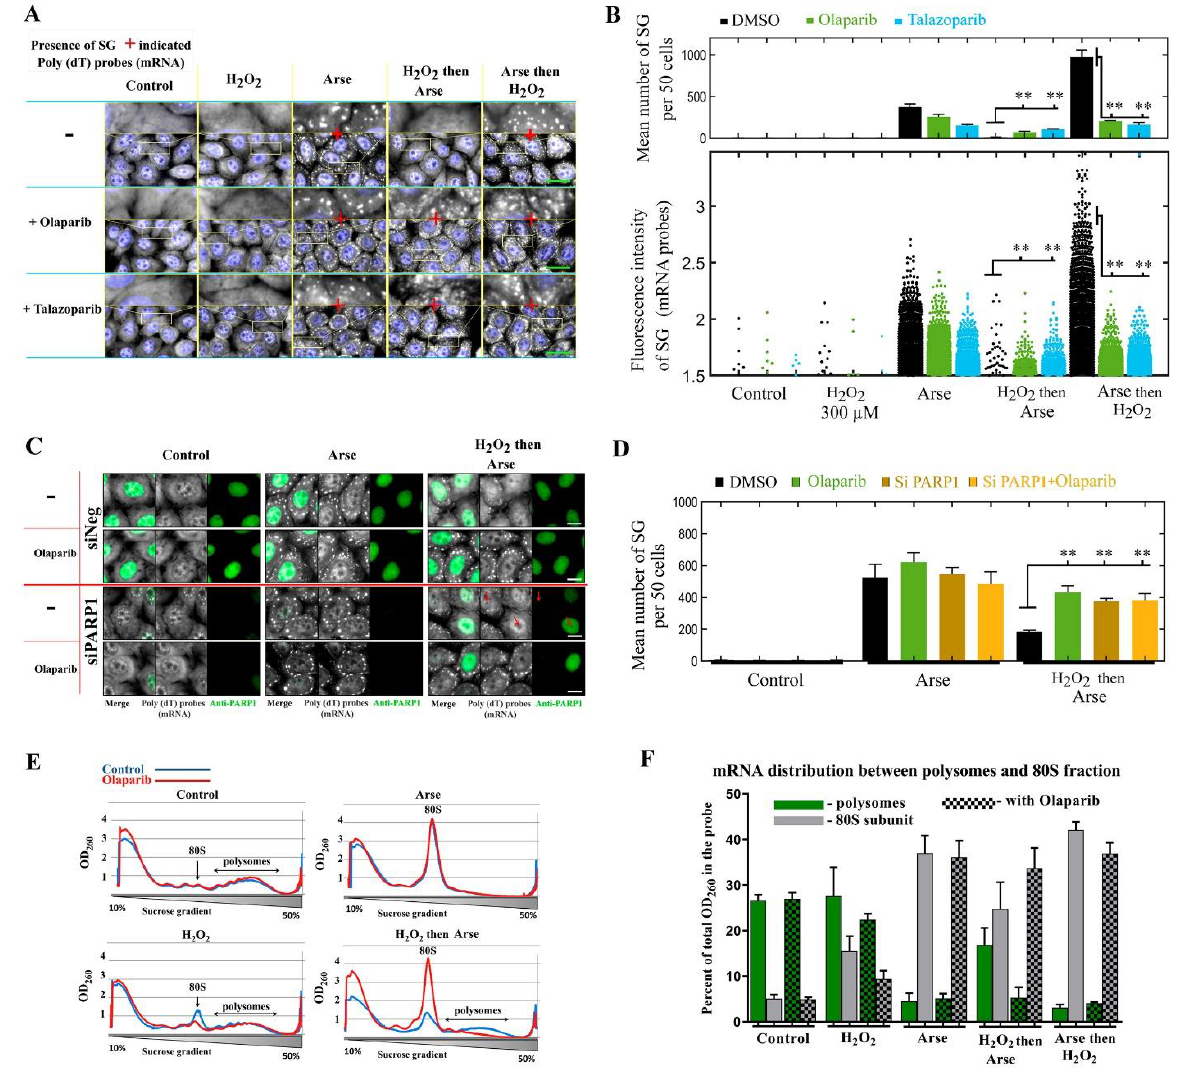
Figure 1. PARP1 activation upon cell exposure to H 2 O 2 prevents polysome dissociation and thus arsenite-mediated SG assembly. ( A ) HeLa cells were exposed to indicated treatments (300 µ M H 2 O 2 for 30 min; 300 µ M arsenite for 60 min). DMSO (control), to inhibit PARP1 10 µ M olaparib or 1 µ M talazoparib were added 1 h prior to indicated treatment. mRNA was then detected to reveal the presence of SGs in the cytoplasm. Blue: DAPI (nuclei). Grey: mRNA (in situ hybridization with cy3-labelled poly(dT) probe). Scale bar: 10 µ m. ( B ) The number of SGs for 50 cells and their fluorescent intensity (in situ hybridization of mRNA) were measured for the indicated conditions. SGs were detected automatically from cell images by using the Cell Profiler software. **, p < 0.001; t -test. ( C ) HeLa cells were treated with siRNA directed against mRNA encoding PARP1 and then exposed to the same treatments as those indicated in ( A ). Scale bar: 10 µ m. ( D ) Mean number of SGs for 50 cells after indicated pretreatment. **, p < 0.001; t test. Green: anti-PARP1 antibody. Grey: mRNA (in situ hybridization with cy3-labelled poly(dT) probe). ( E ) Polysome profiles obtained from cells treated with arsenite, H 2 O 2 or H 2 O 2 /arsenite. Cytoplasmic lysates of HeLa cells obtained from indicated conditions were fractionated through sucrose gradients. ( F ) Sucrose gradient (10–50%) profile analysis of mRNA distribution between polysomes and 80S fraction. Fractions corresponding to polysomes and 80S ribosomes are indicated. Treatment is the same as those indicated in ( A ). As H 2 O 2 treatment does not cause the phosphorylation of eIF2A, in contrast to arsen- ite [36], we tested the hypothesis that massive eIF2A phosphorylation can be affected by cell pretreatment with puromycin and puromycin/H 2 O 2 and also in combination with